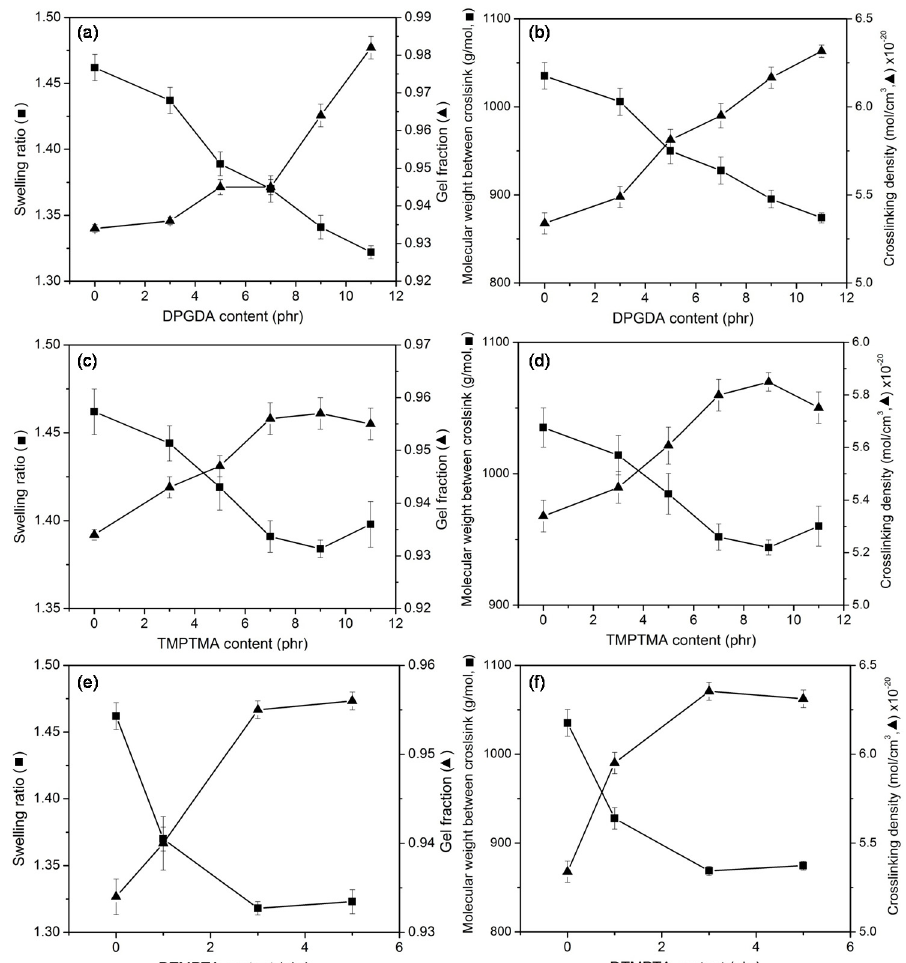
Figure 4. Swelling ratio and gel fraction ( a , c , e ), and molecular weight between the crosslink and crosslinking density ( b , d , f ) of UFPNR prepared with different types and contents of coagent.